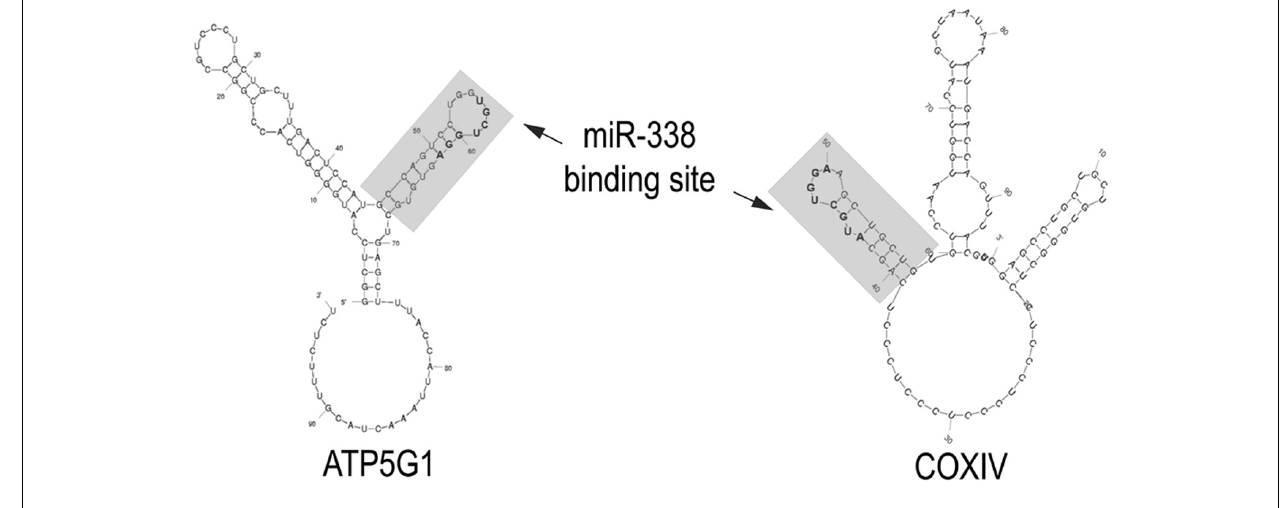
FIGURE 1 | miR-338 binding sites in nuclear-encoded mitochondrial mRNAs present in the axon. The secondary structure of the 3 (cid:2) UTRs of CoxIV and ATP5G1 mRNAs were predicted by Mfold analyses.The